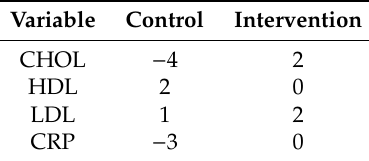
Table 5. Number of people that have moved from having an unhealthy value to a healthy value during the intervention. Variable Control Intervention CHOL − 4 2 HDL 2 0 LDL 1 2 CRP